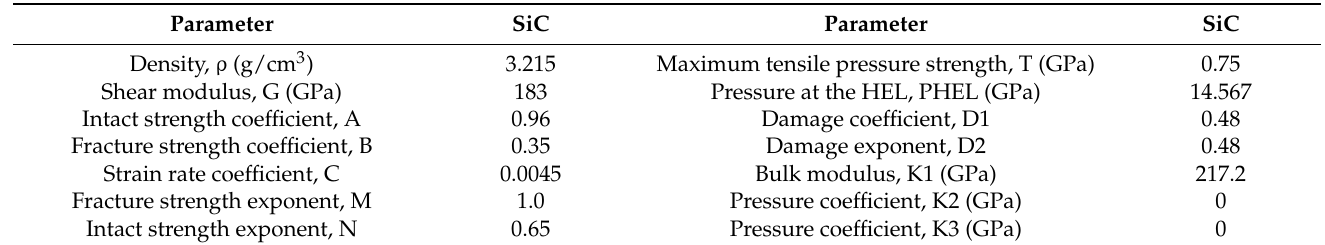
Table 5. Parameters of ceramic material in the Johnson–Holmquist-2 model [25].